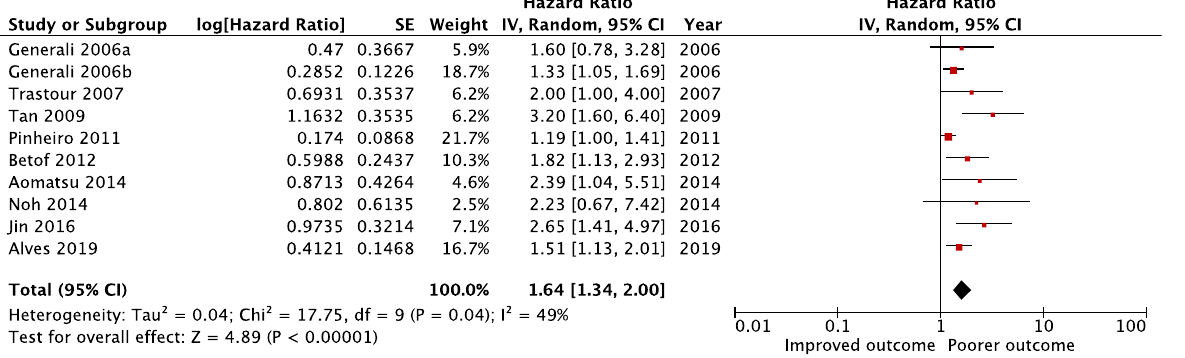
Fig. 3 Forest plot for the relationship between CAIX expression and disease-free survival in breast cancer patients